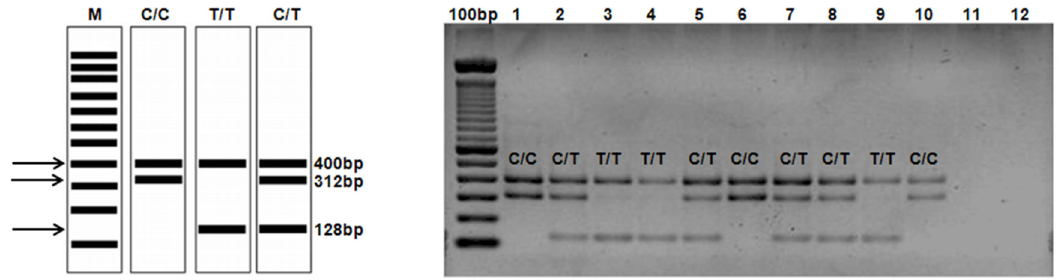
Figure 2. Standardization of PCR-CTPP. A - Graphic of the expected result in gel electrophoresis. B - The genotype analysis was performed by differentiatingthe size of fragments; the homozygous C/C gives bands of 400 bp and 312 bp, the homozygous T/T gives bands of 400 bp and 128 bp, and the heterozygote genotype yields bands of 400 bp, 312 bp, and 128 bp. The lanes 1 to 3 represent positive controls. The shafts 4 to 10 represent samples and 11 and 12 negative controls. doi: